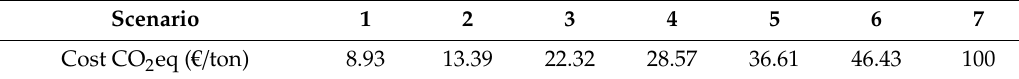
Table 1. Cost per ton of CO 2 eq in carbon emission tax (Case 1).